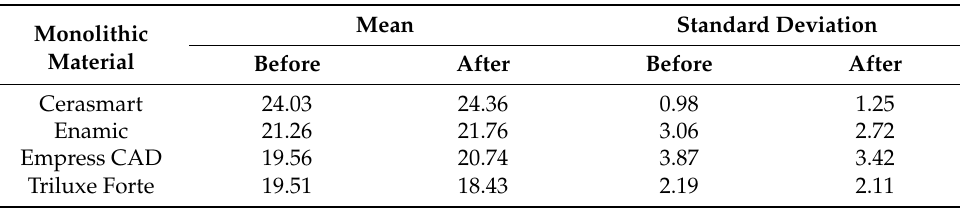
Table 3. Translucency parameters, before and after 18 h of simulated gastric acid solution exposure: mean and standard deviation.